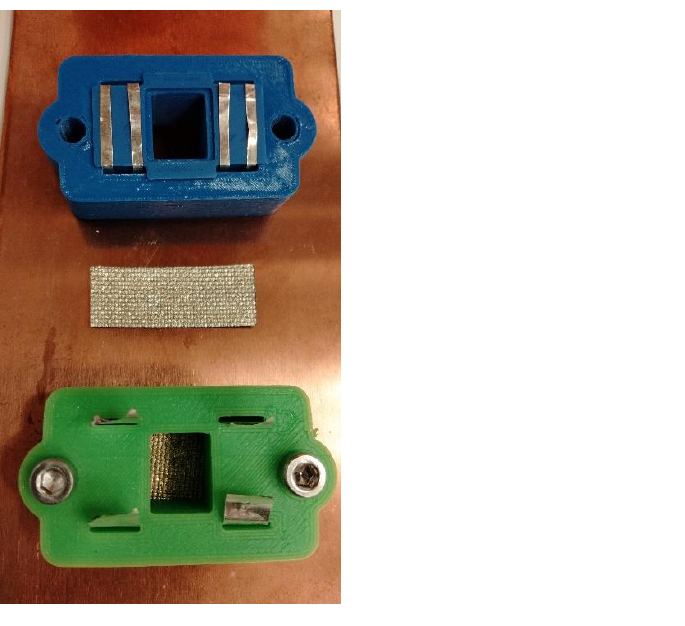
Figure 2. View of the sample in the holder mounted on the heat exchanger.